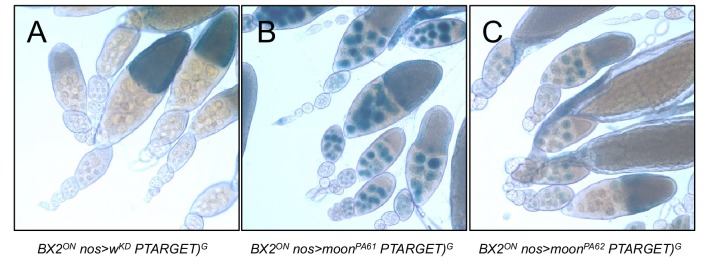
BX2ON silencing depends on moonshiner.ß-Galactosidase staining of ovaries from females harboring BX2ON, P(TARGET)G, the nosGAL4 driver and a RNAi against the white gene as a control (A) or a RNAi against moonshiner (moonPA61 and moonPA62, B and C, respectively). Both of the moon knockdown lines affect the silencing induces by BX2ON showing that moonshiner is required for the BX2ON state.